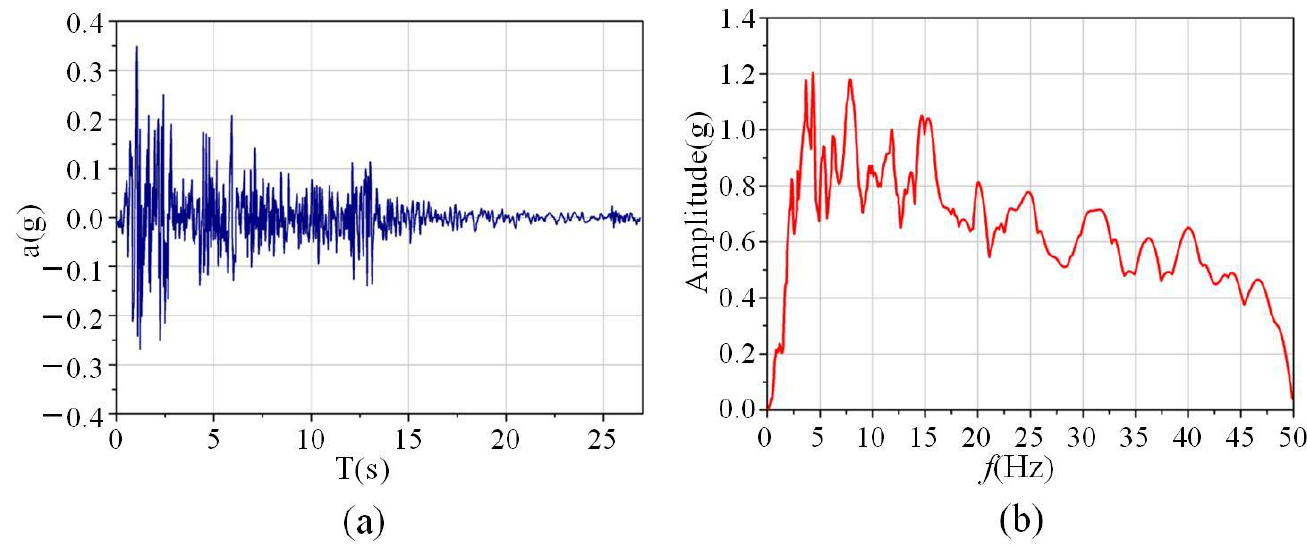
Figure 3. Inputted earthquake: ( a ) time history acceleration; ( b ) response spectra [19].